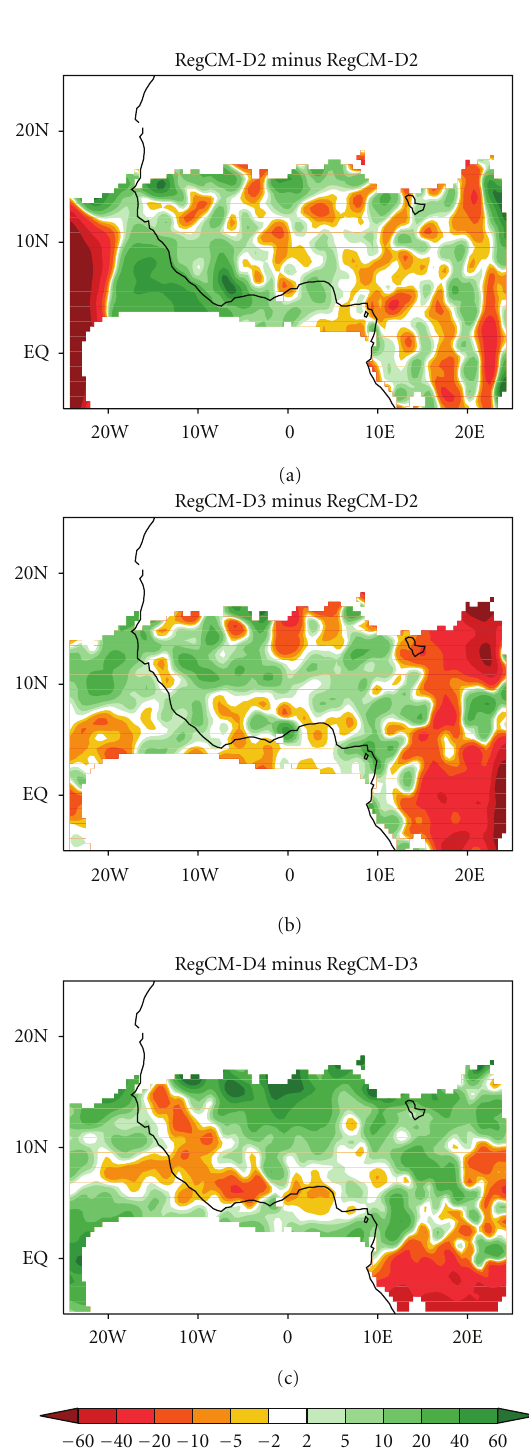
Figure 4: Di ff erences among the simulations of mean JJA rainfall between (a) RegCM-D2 and RegCM-D1, (b) RegCM-D3 and RegCM-D2, and (c) RegCM-D4 and RegCM-D3. Units are expressed as percentage of, respectively, RegCM-D1, RegCM-D2, and RegCM-D3 values.